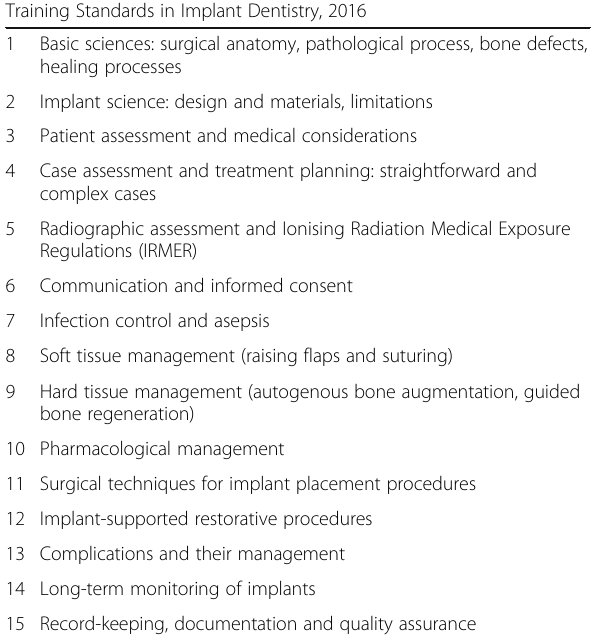
Table 1 Training standards in FGDP (UK) TSID 2016 guideline